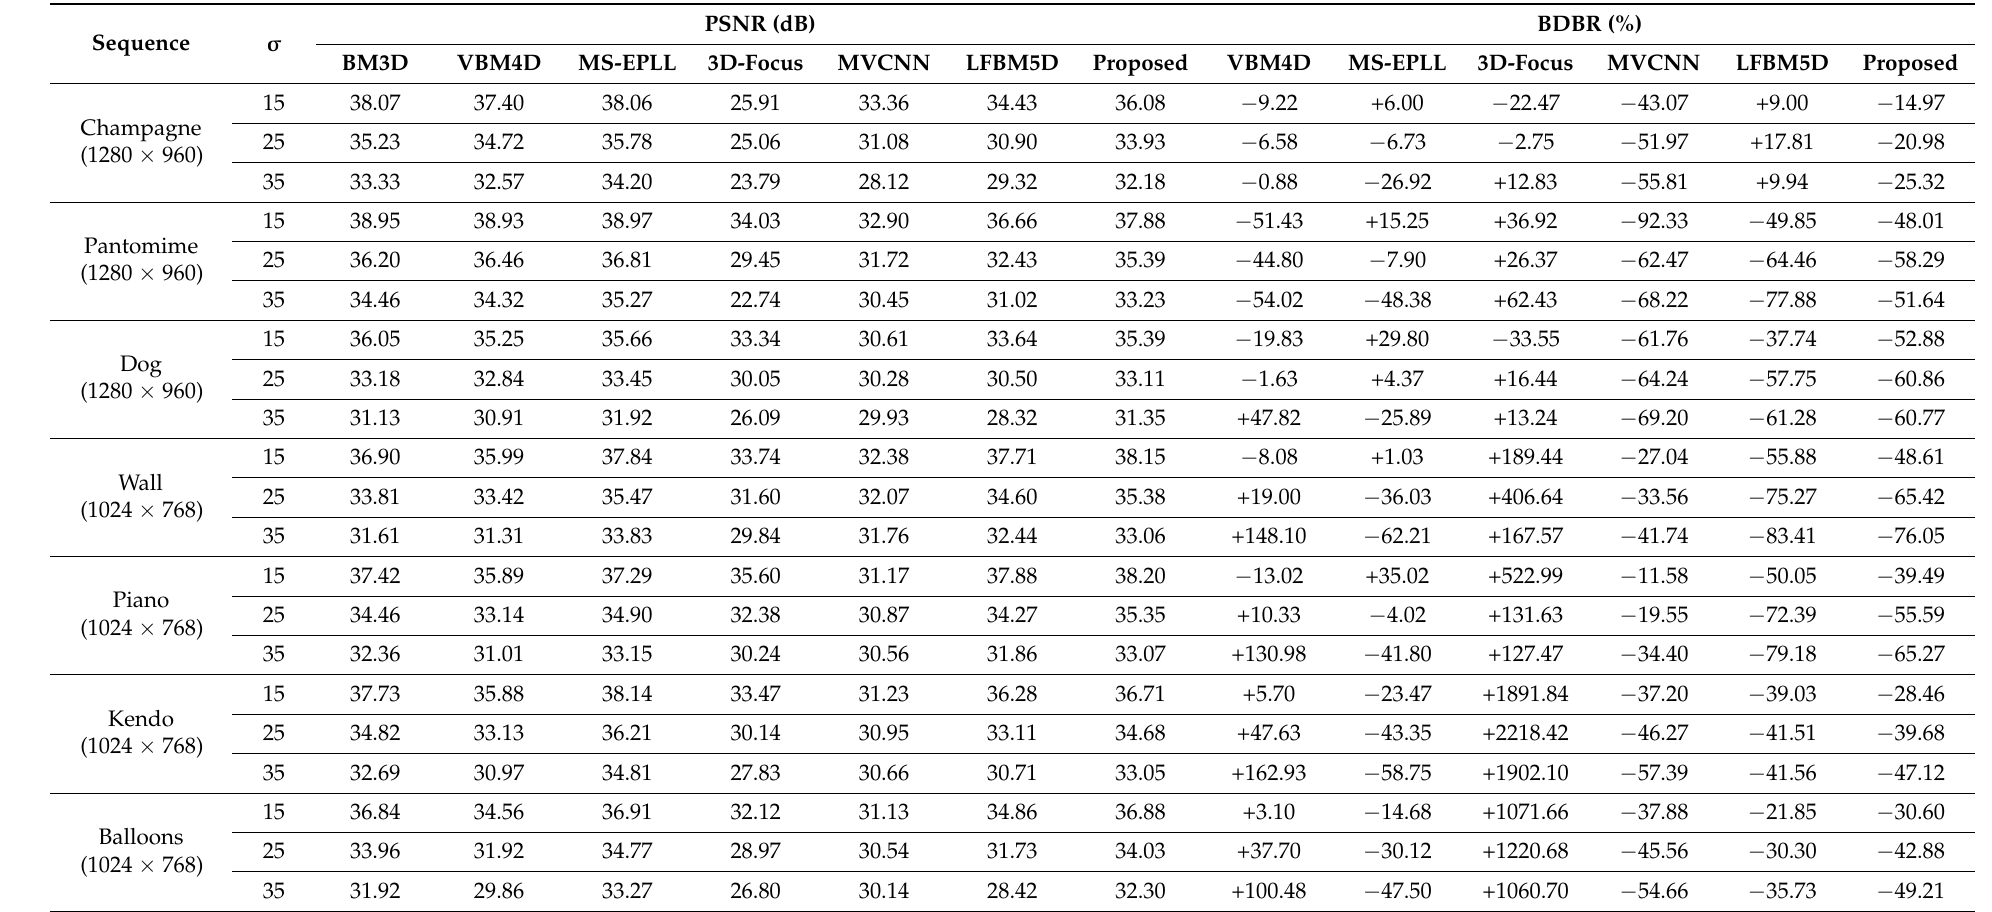
Table 2. Comparison of performance for noisy